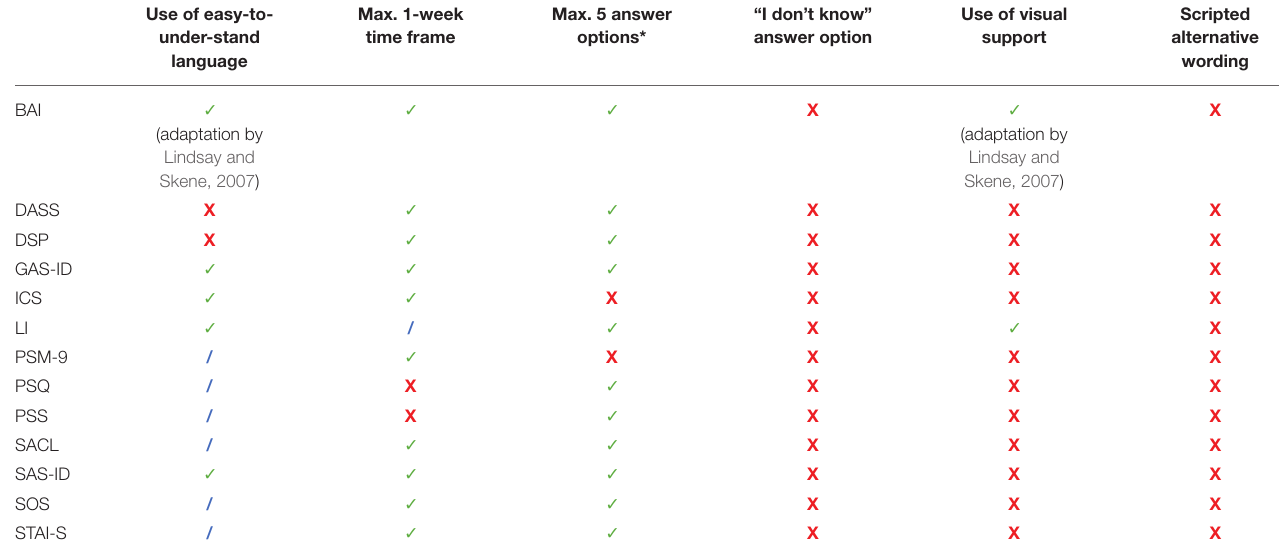
TABLE 3 | Factors that determine the suitability of included self-report stress measures for people with MID according to the expert consultation. Use of easy-to-